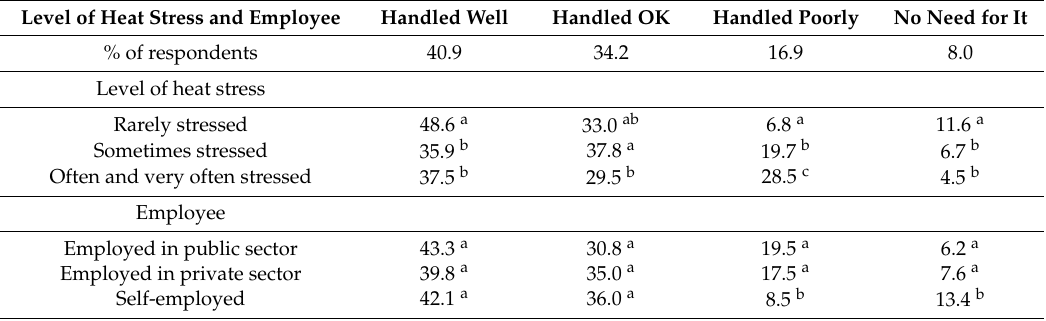
Table 6. Opinion about how heat stress prevention and relief is managed at respondents’ workplace (% of respondents)—by degree of heat stress and employee (N =